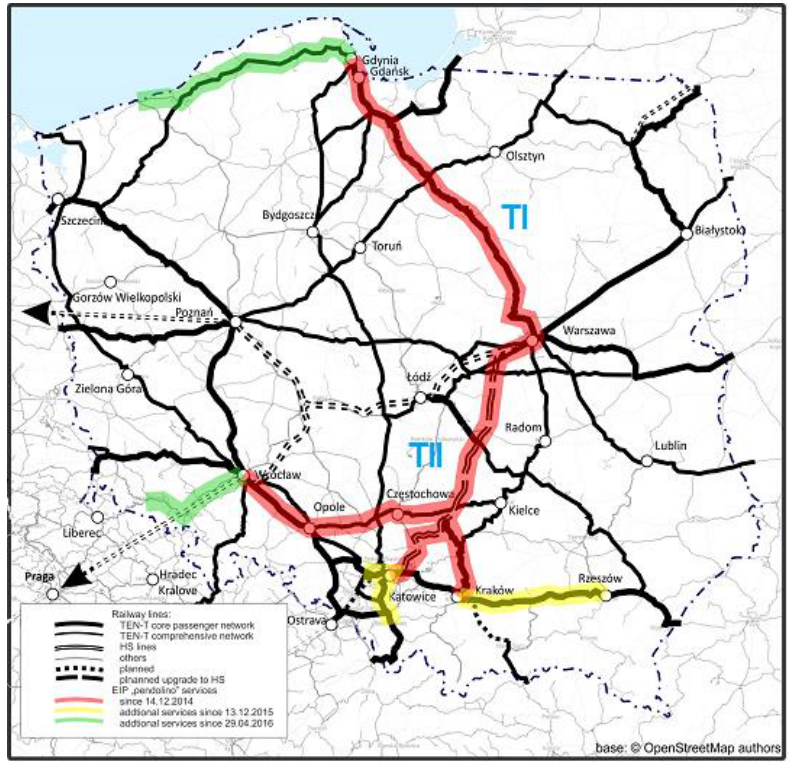
Figure 7. EIP (ED250) services since 14 December 2014. Source: T. Bużałek, based on: © Open- StreetMap authors.